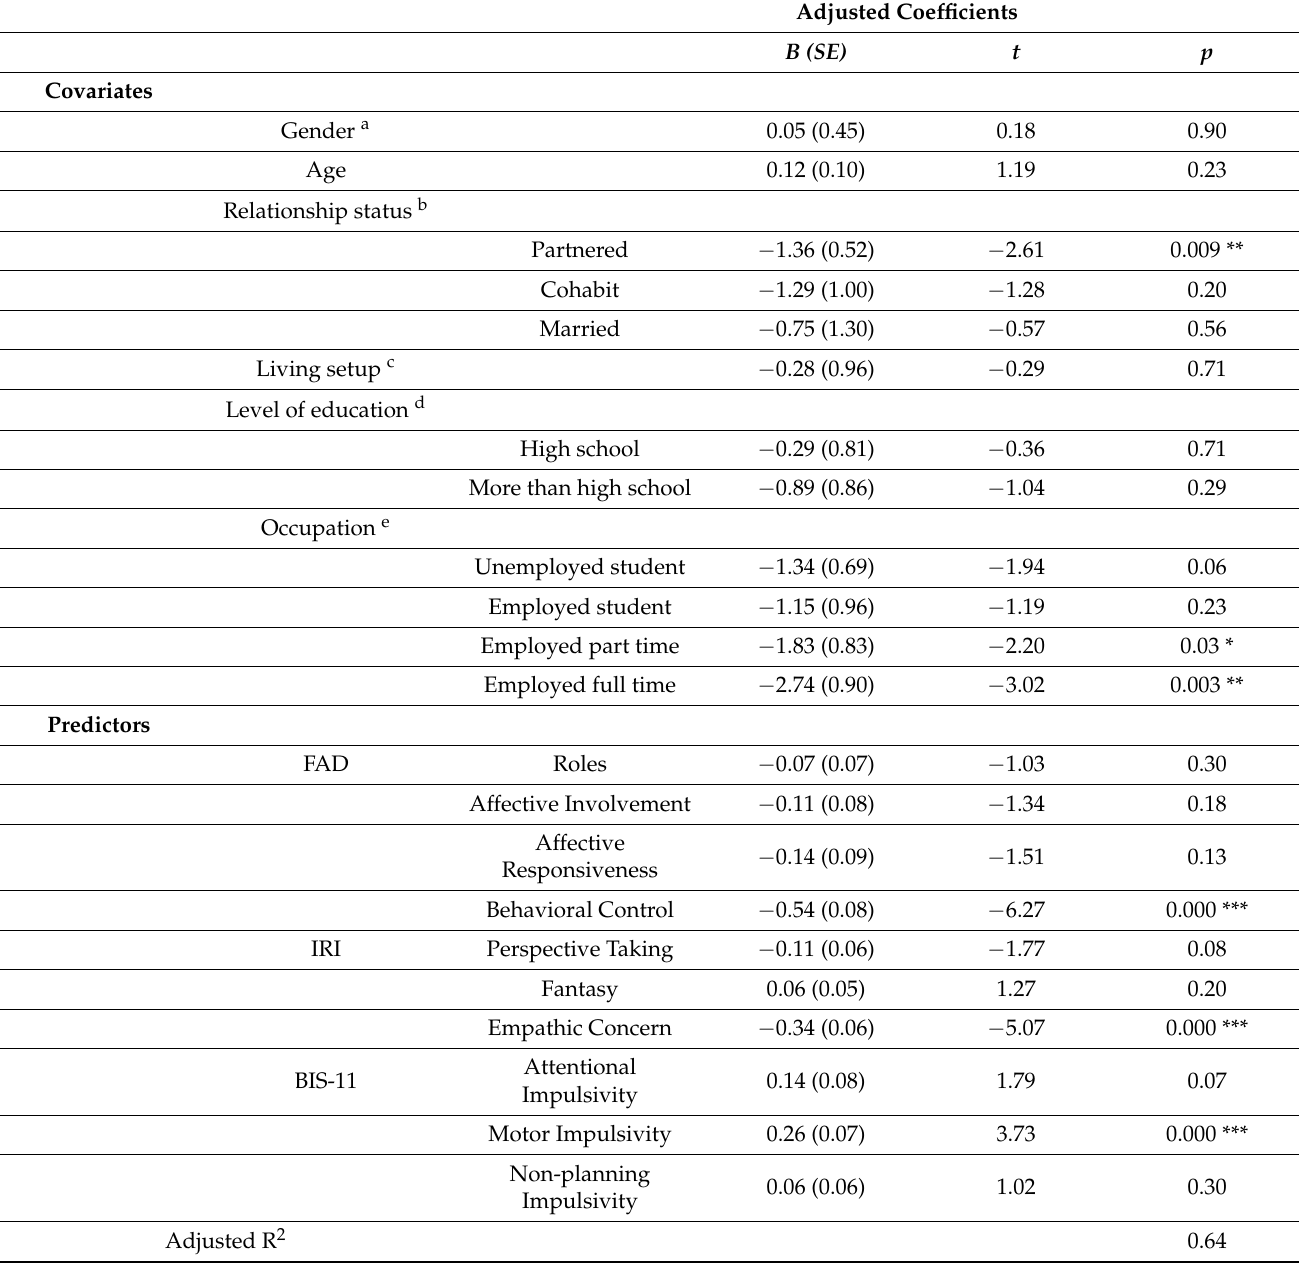
Table 3. Results of hierarchical regression analyses predicting emerging adults’ antisocial personality problems.